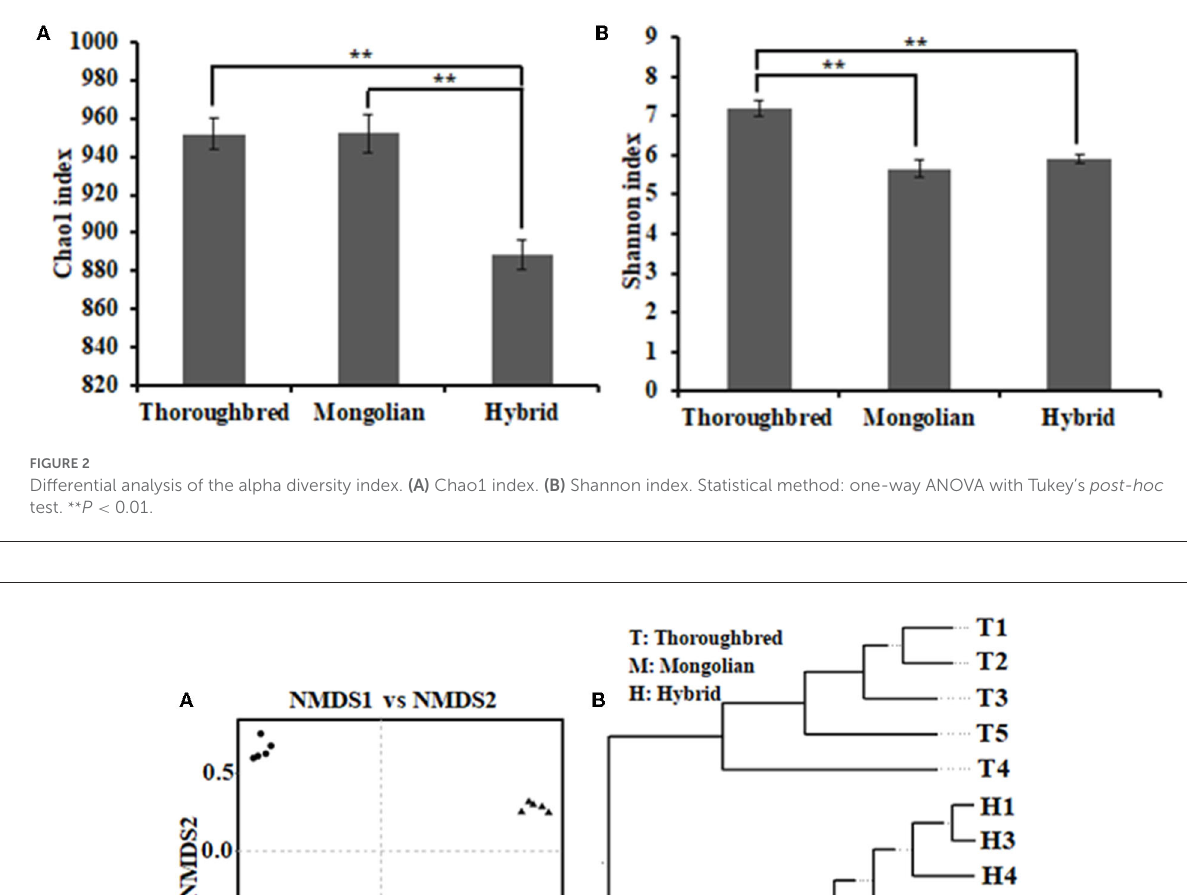
(Figure 3A). Sample hierarchical clustering trees (Figure 3B) showed that Mongolian and Hybrid horses shared higher similarities in microbial compositions.